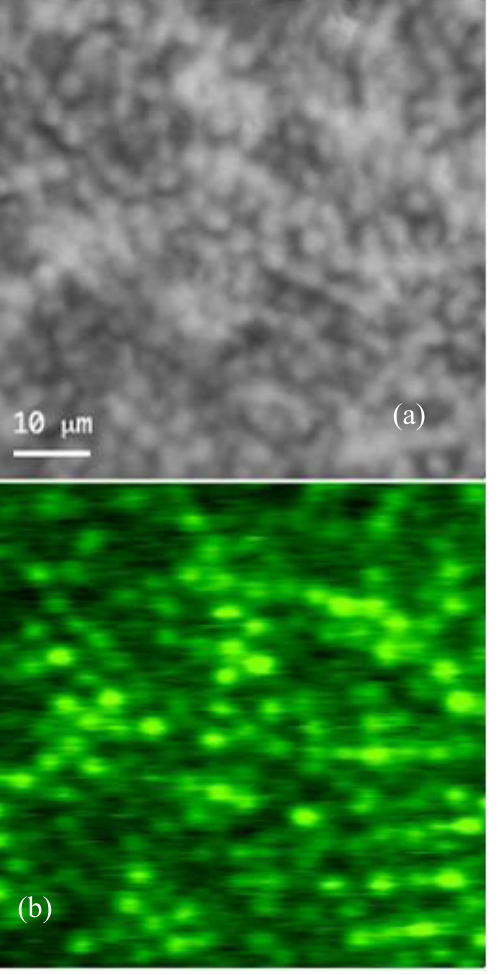
Figure 3 (a) Transmission image and (b) SRL image of a polystyrene beads sample with a diameter of 3